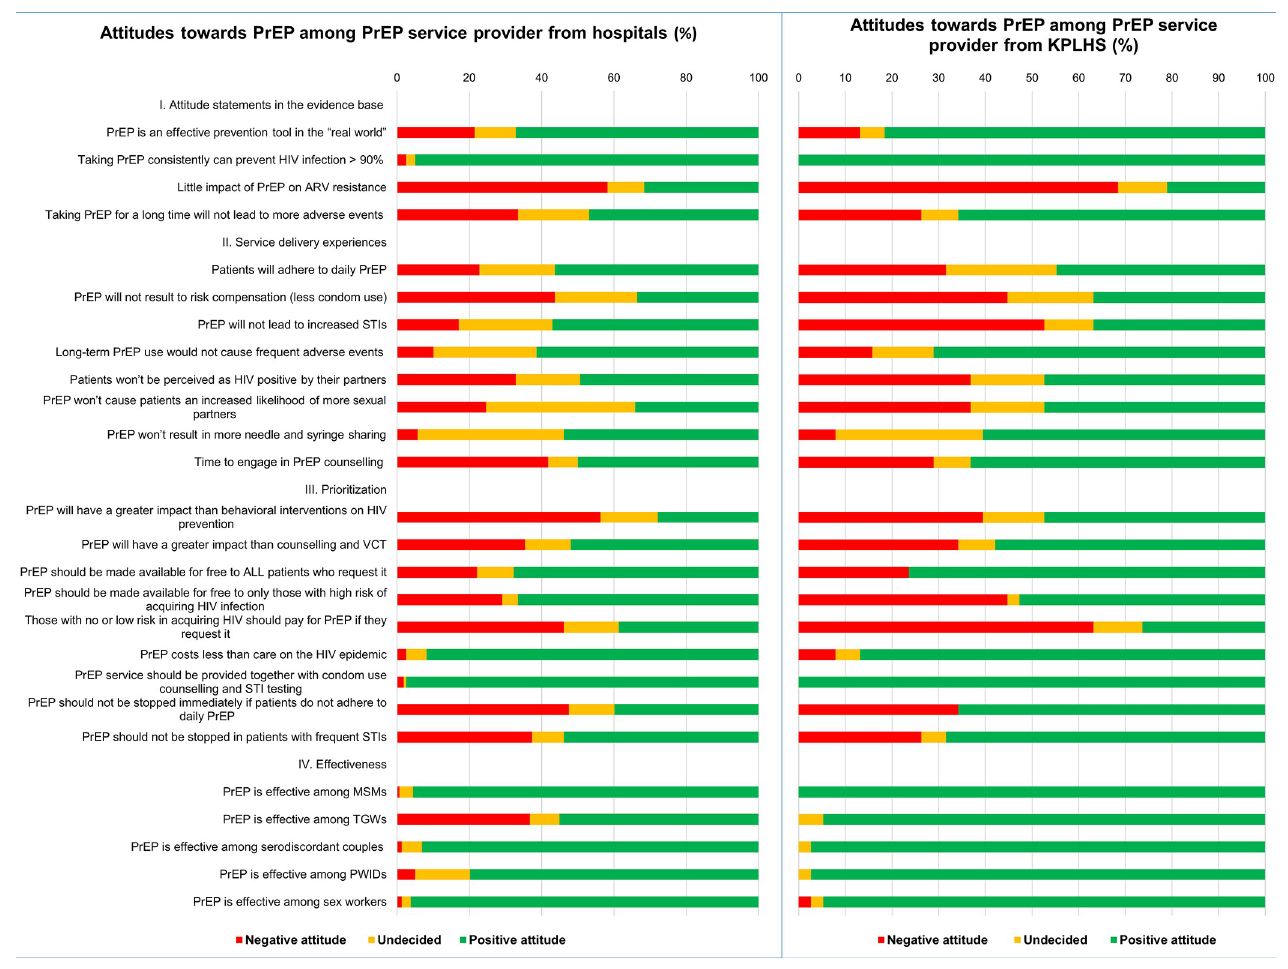
Fig 2. Service providers’ attitudes towards PrEP